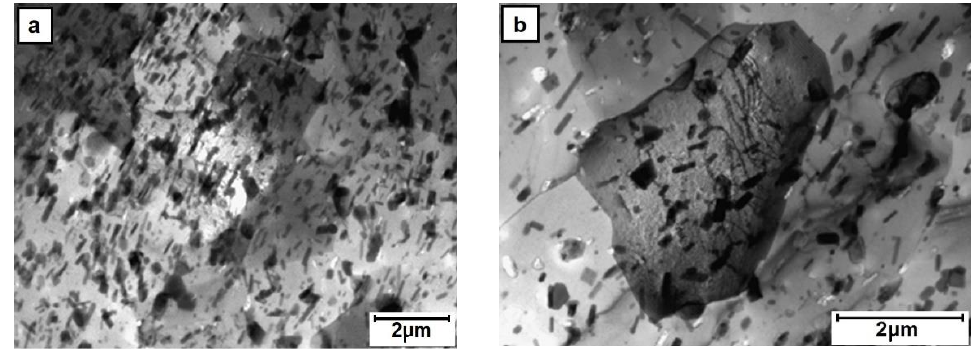
Figure 9. TEM microstructure of the outer-zone area (E / 224 rpm) presenting presence of: ( a ) extra-fine and ( b ) fine grain areas.